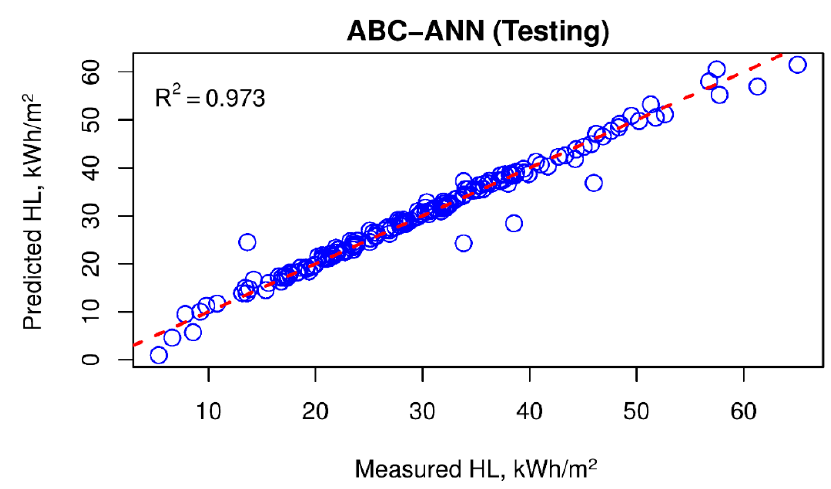
Figure 21. HL predictions on the testing dataset of the ABC-ANN model.